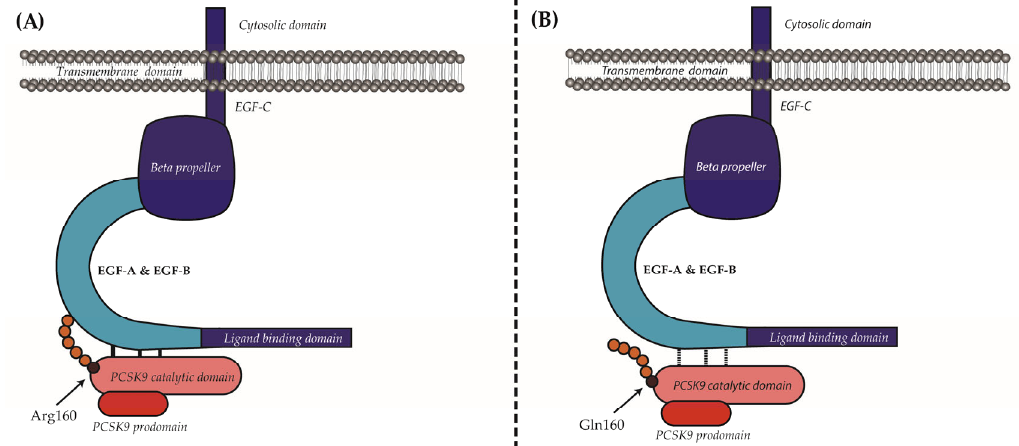
Figure 6. Suggested mechanisms leading to loss of affinity of the p.(Ard160Gln) PCSK9 variant for the LDLr. ( A ) Upon prodomain cleavage, P ′ helix is located next to the LDLr ‐ binding site and strengthens the electrostatic forces for binding and maintaining the PCSK9 ‐ LDLr complex. Additionally, the Arg160 residue forms a salt bridge with the LDLr Asp343 residue. ( B ) Replacement of Arg160 by a Gln modifies the change the direction of rotation of the P’ helix, which no longer remains close to the EGF ‐ A residues implicated in PCSK9 binding.